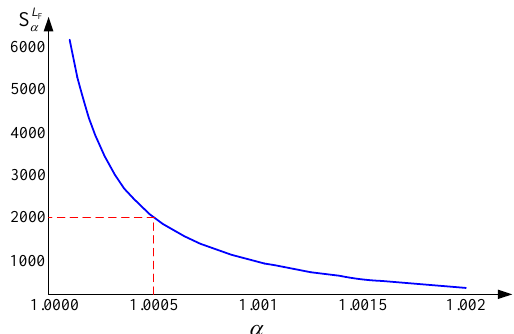
L F α and α . and α . Figure 13. The relationship between S 